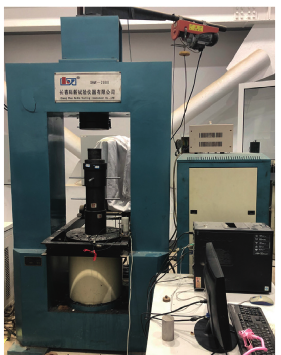
Figure 5: The Saw-2000 rock testing machine to conduct the uniaxial compressive